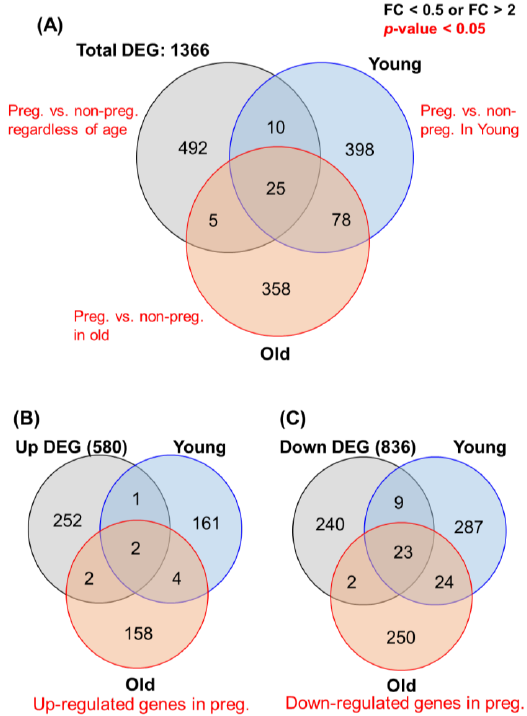
Figure 2. Total transcriptome profiling depending on sample criteria, based on DEG analysis of NGS data. ( A ) Venn diagram of significantly up- or downregulated genes (fold-change ≥ 2) in the four groups (young/old, pregnancy/non-pregnancy). A total of 1366 genes were included in the RNA-seq analysis: pregnancy vs. non-pregnancy regardless of age (492 genes), pregnancy vs. non-pregnancy in the young group (398 genes), and pregnancy vs. non-pregnancy in the old group (358 genes). ( B ) Venn diagram of 580 upregulated genes in the pregnancy group (young and old). ( C ) Diagram of 836 downregulated genes in the pregnancy group (young and old). Data are presented as means ± SEM of three replicates. Significant differences are indicated by asterisks (* p < 0.05).